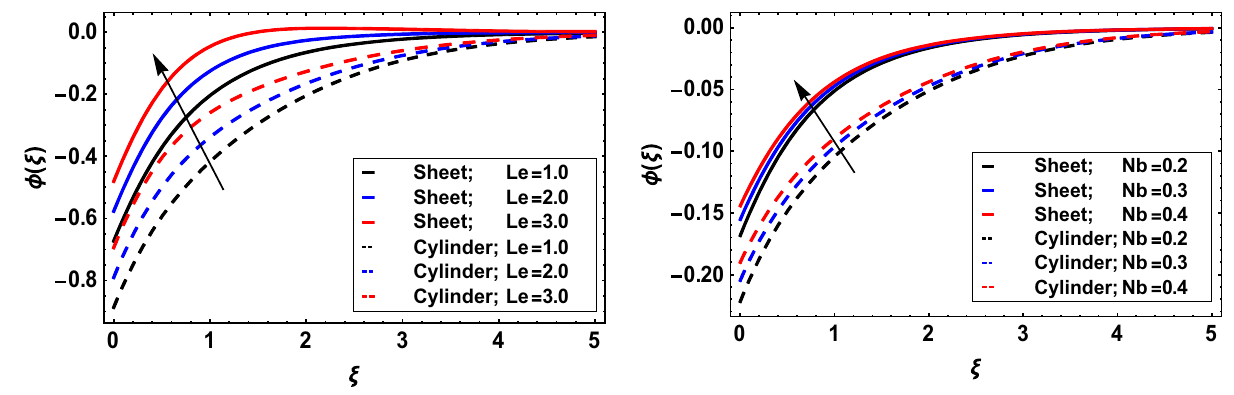
Figure 12: Change in nano fl uid concentration due to Nb